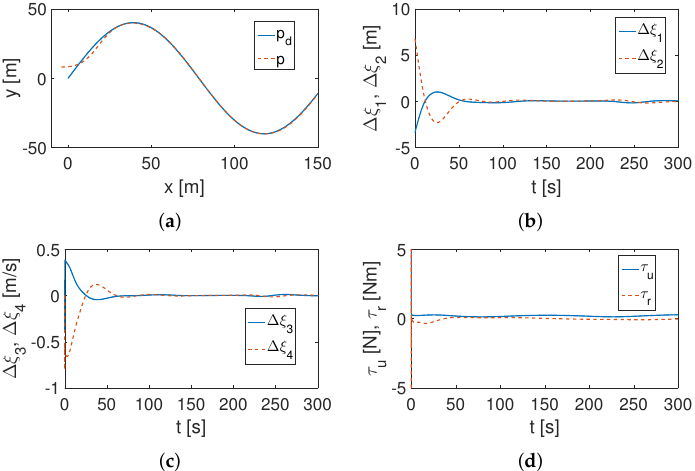
Figure 9. Simulation results for XX AUV original controller (CL) and sine trajectory: ( a ) desired and realized trajectory; ( b ) position error states; ( c ) velocity error states; and ( d ) applied force and